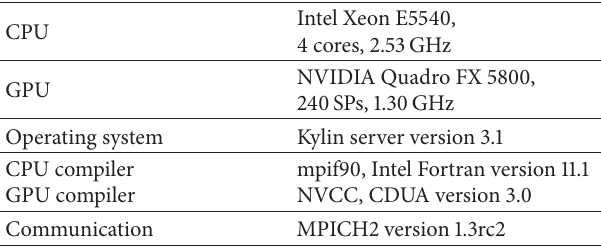
Table 1: Technical specifications of experiment platforms.